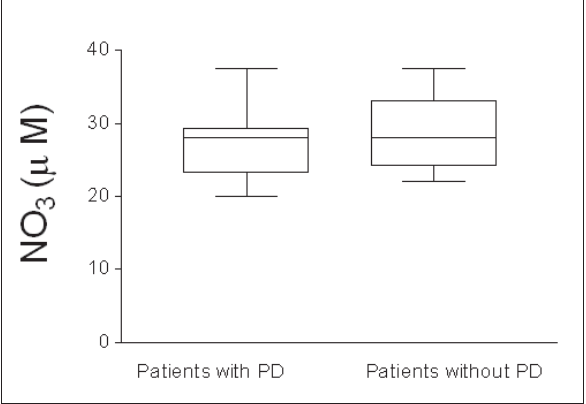
Fig. 4: Nitrate levels in plasma of peripheral blood from Down’s syndrome patients with and without periodontal disease. Nitrate concentration was determined by the Griess method. Data are reported as means ± standard error of means of the assays performed in triplicate and representative of three different experiments.